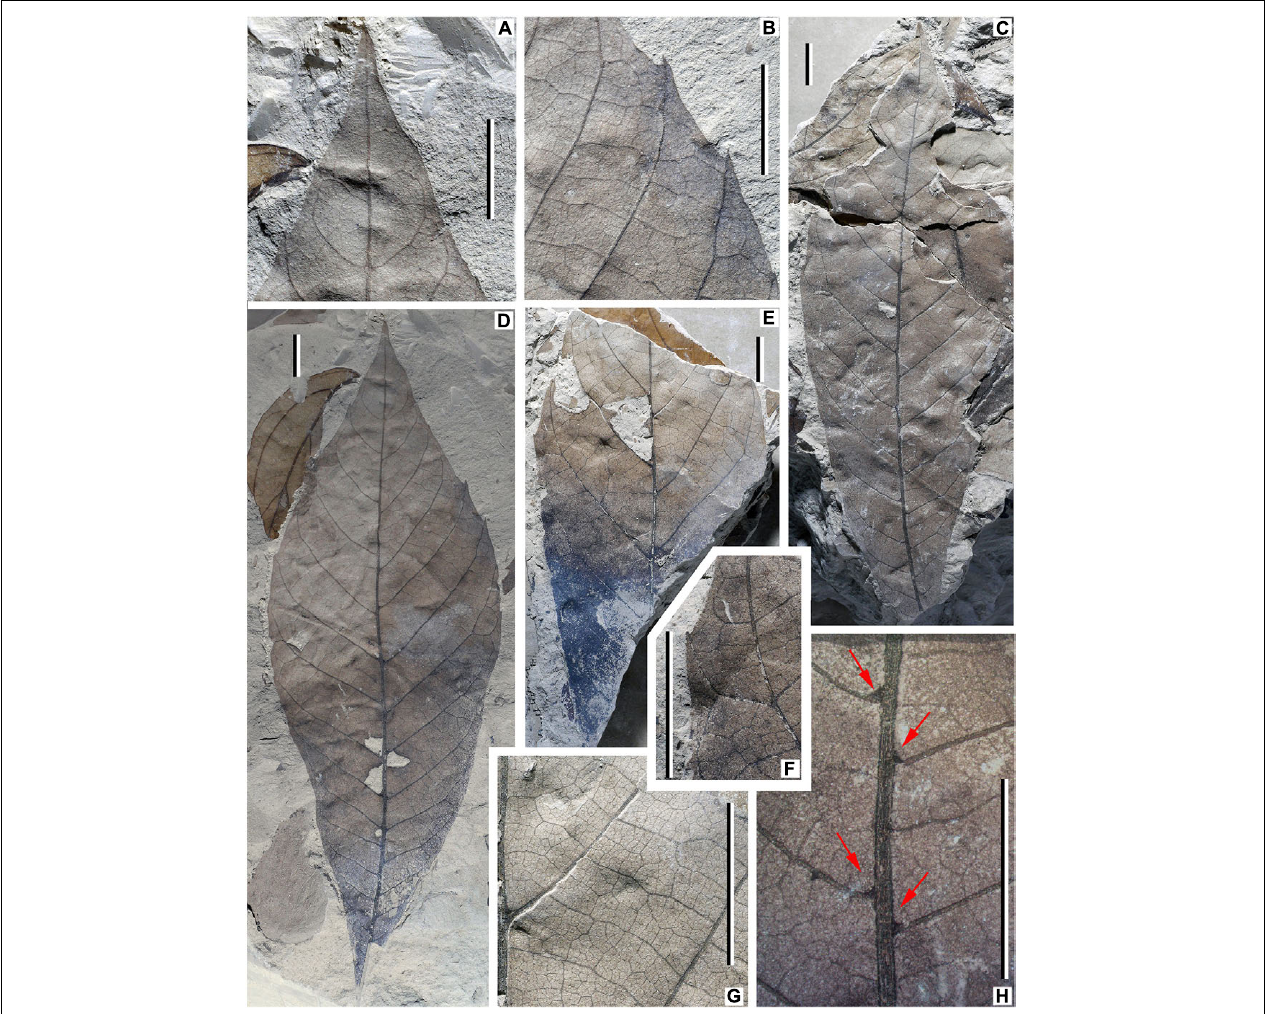
FIGURE 3 | Fossil leaves of Meliosma eosinica sp. nov. from the Eocene Huangniuling Formation of the Maoming Basin, South China. (A,B,D) Holotype, MMJ3-008-1a. Note insect leaf-feeding damage in (D) small circular hole (damage type DT2) and a cluster of three holes located at the divergence point of secondary veins from primary veins (DT57) with a narrow reaction rim. (C) Untoothed leaf, MMJ3-2175-1a. Note polylobate insect feeding holes (DT3) with weakly developed reaction tissue. (E) Incompletely preserved leaf showing insect marginal feeding (DT15), hole feeding (DT5), and surface feeding (DT31) traces, MMJ3-837-3a. (F,G) Enlargement of leaf in (E) . (H) Enlargement of leaf in (C) showing domatia (arrows). Scale bars = 1